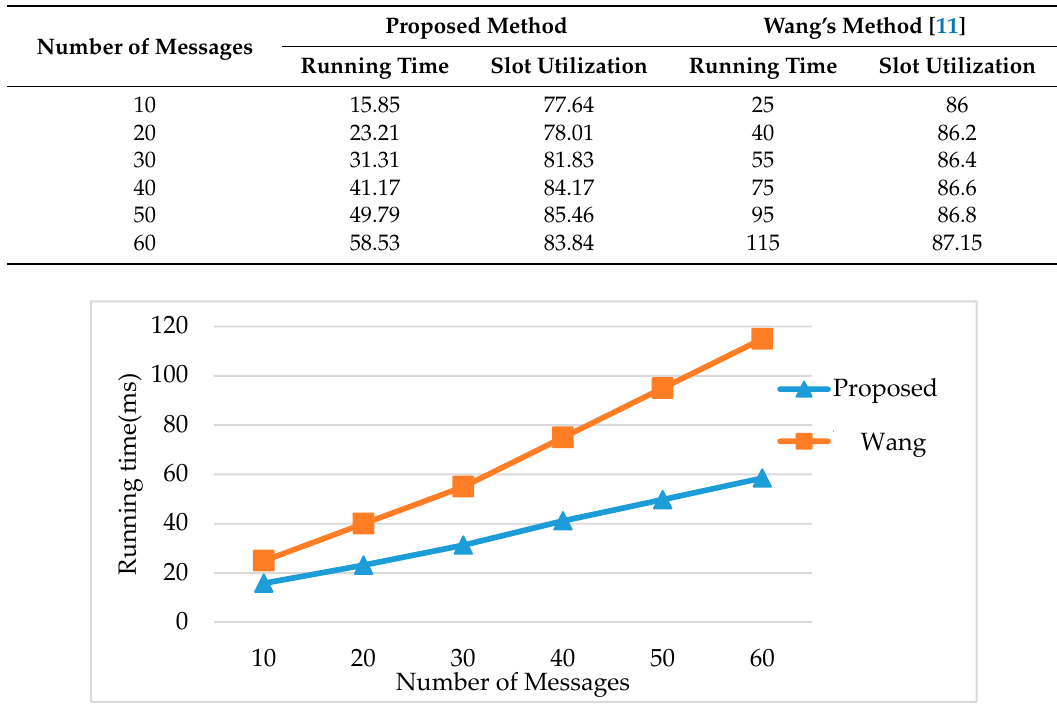
Table 4. Comparison of running time and slot utilization with Wang’s method.